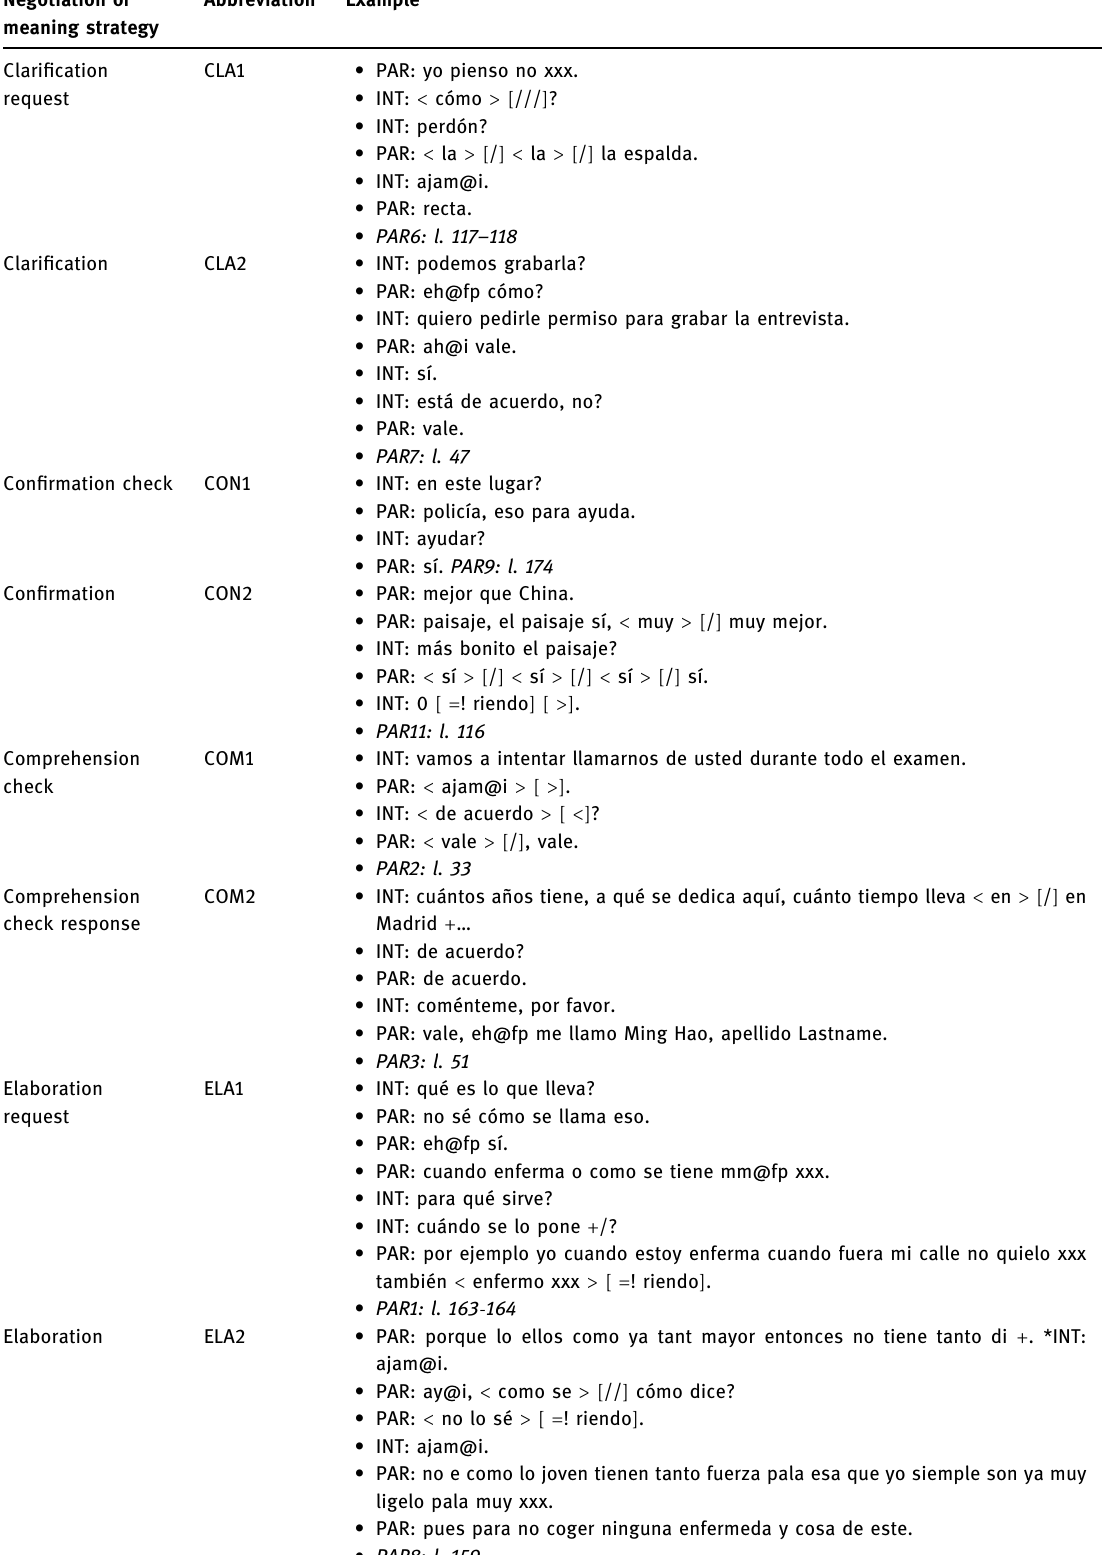
Annex 2: Strategies for negotiation of meaning included in the study: abbreviations and